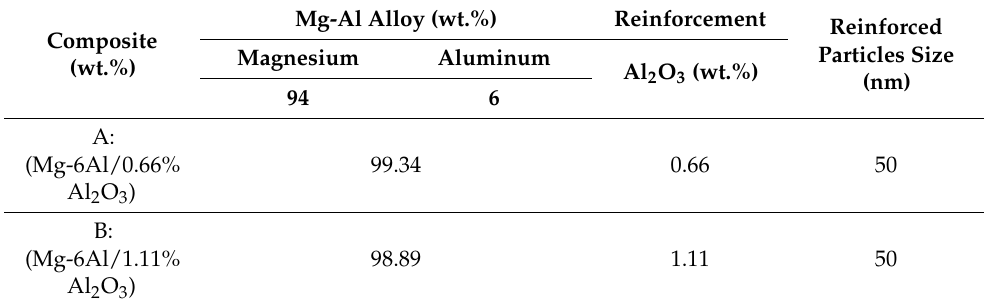
Table 1. Chemical composition of nanocomposites.